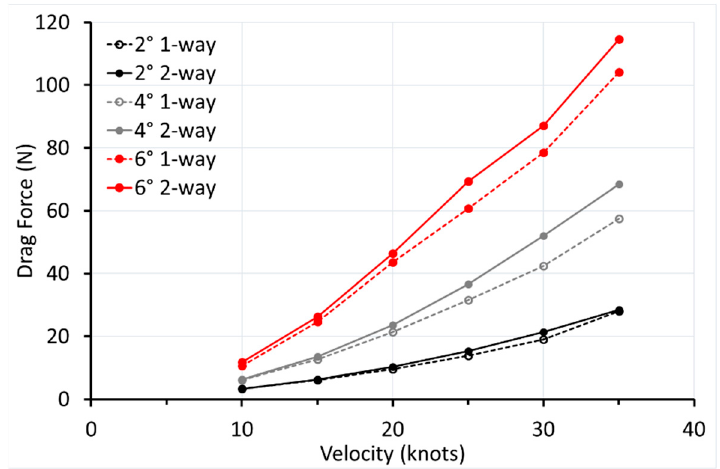
Figure 7. Drag force vs. velocity.